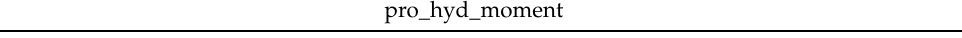
Table 6. Common selected features between ADORA2A and ADRB2 having a feature score of 3. pro_hyd_moment